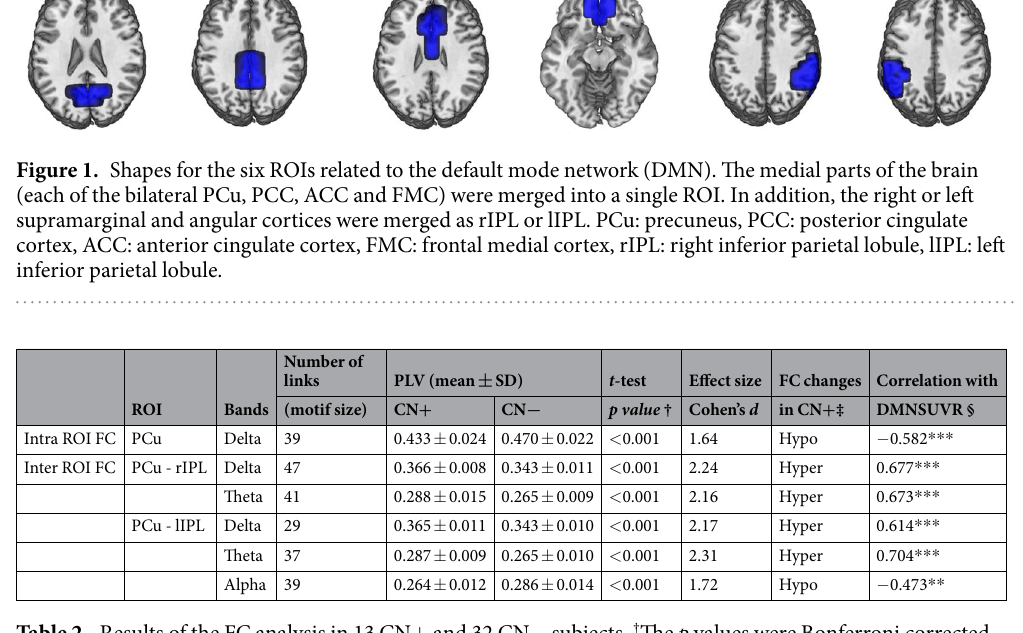
Table 2. Results of the FC analysis in 13 CN + and 32 CN − subjects. † The p values were Bonferroni corrected by multiplying by 5 (the number of frequency bands). ‡ FC changes in the CN + group compared with the CN − group. Hypo, decreased connectivity in the CN + ; Hyper, increased connectivity in the CN + . §Correlation coefficient ( r ) for each FC value with PiB mean standardized uptake value ratio (SUVR) value within the default mode network (DMN) ROIs (DMNSUVR). The asterisks indicate statistically significant correlations ( * p < 0.05, ** p < 0.01, *** p < 0.001). PCu: precuneus, rIPL: right inferior parietal lobule, lIPL: left inferior parietal